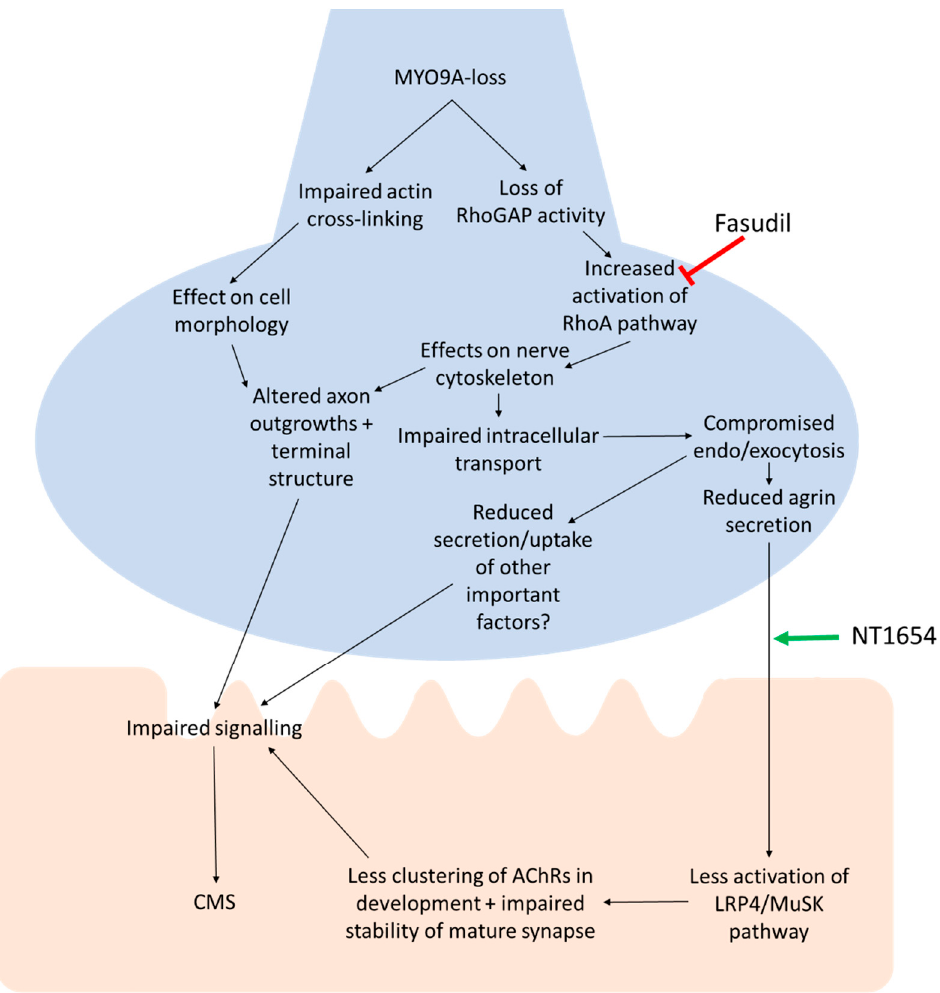
Figure 6. Proposed pathway of action for MYO9A-dysfunction at the NMJ. The pathway begins with loss or dysfunction of MYO9A and the predicted effect of this on a number of downstream processes, culminating in impaired neuromuscular transmission and Congenital Myasthenic Syndromes (CMS). The points of action for fasudil (ROCK inhibitor) and NT1654 (agrin-fragment) are shown. Green arrow = positive action, red arrow = inhibits action.